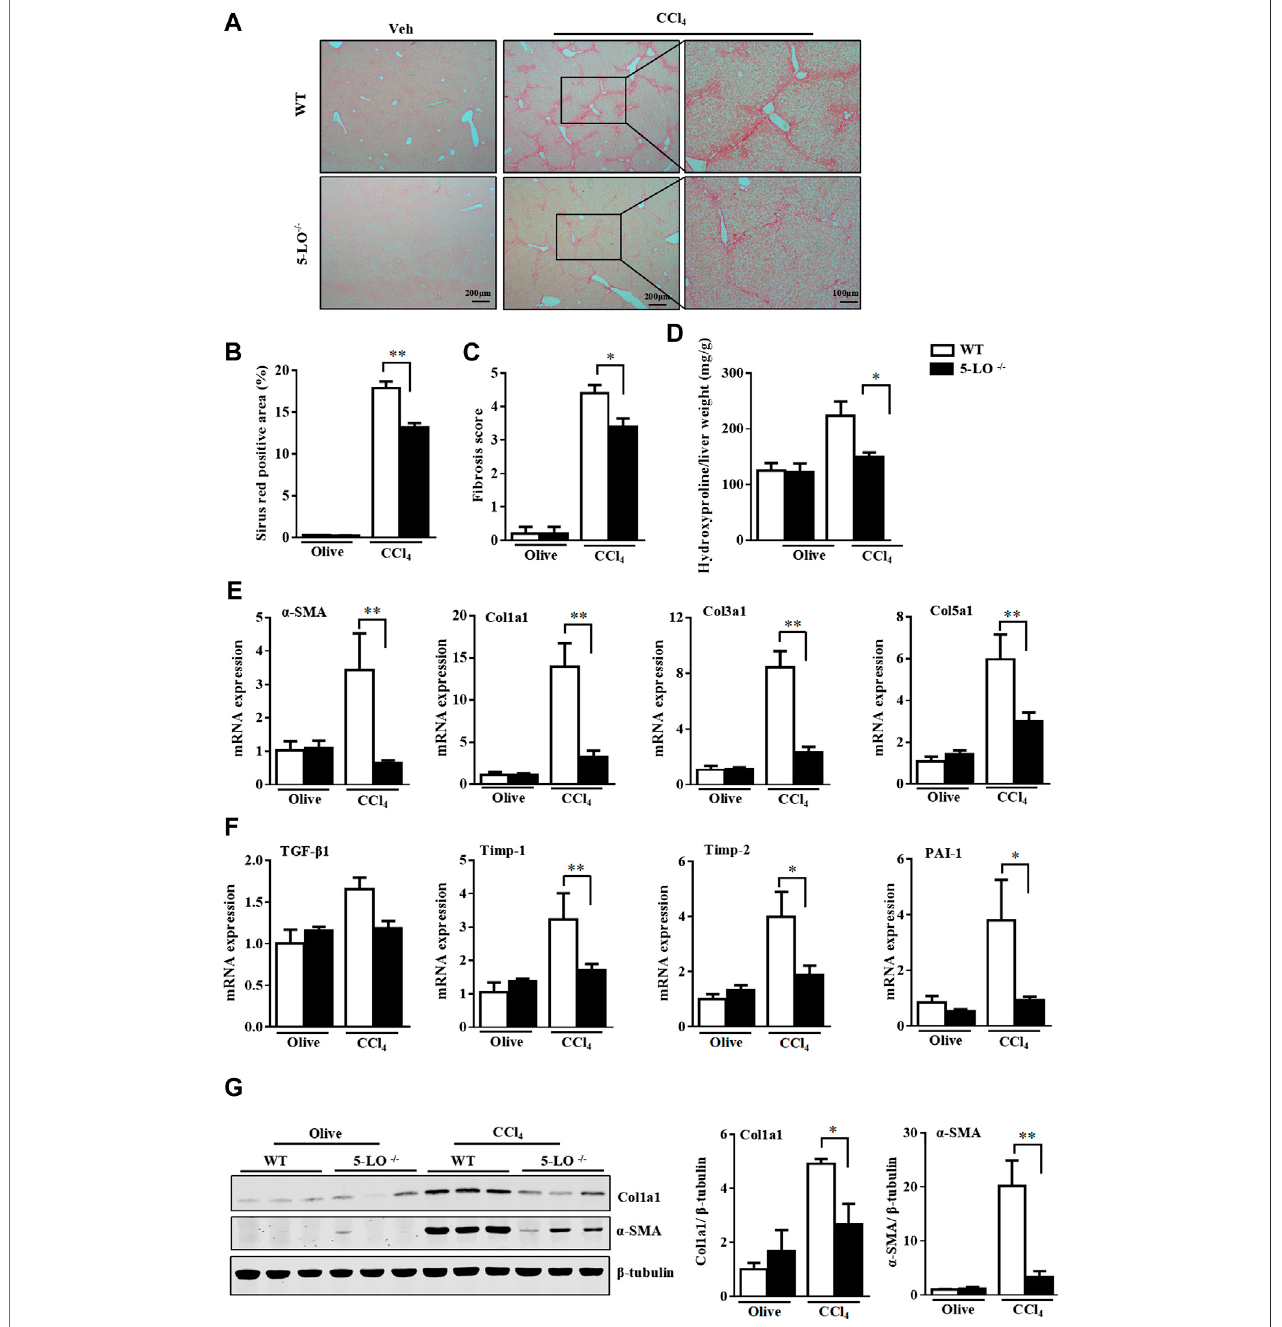
FIGURE 5 | Genetic ablation of 5-LO ameliorated liver fi brosis after CCl 4 injection. WT and 5-LO − / − mice were treated with olive oil or CCl 4 for 8 weeks. Fibrosis stagewasassessedbypicrosiriusredstaining (A,B) forcollagenaccordingtotheIshakcriteria (C) . (D) Detectionofhepatichydroxyprolinelevel. (E,F) qRT-PCRanalysis of mRNA levels of fi brosis genes in livers of 4 groups. (G) Western blot analysis of the protein levels of α -SMA and Col1a1. Data are mean ± SEM, n (cid:2) 7, * p < 0.05, ** p < 0.01.